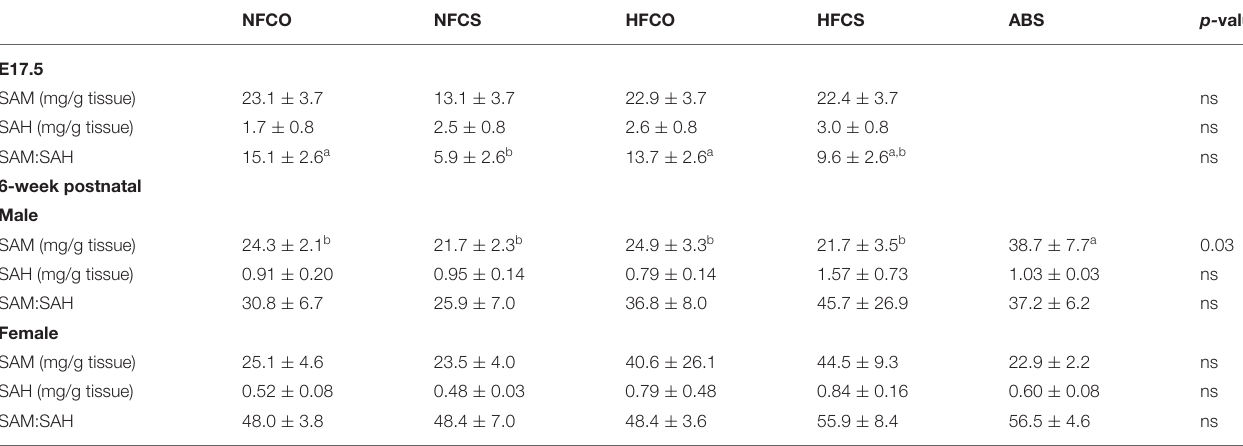
TABLE 1 | SAM and SAH concentrations in fetal and postnatal livers. NFCO NFCS HFCO HFCS ABS p- value